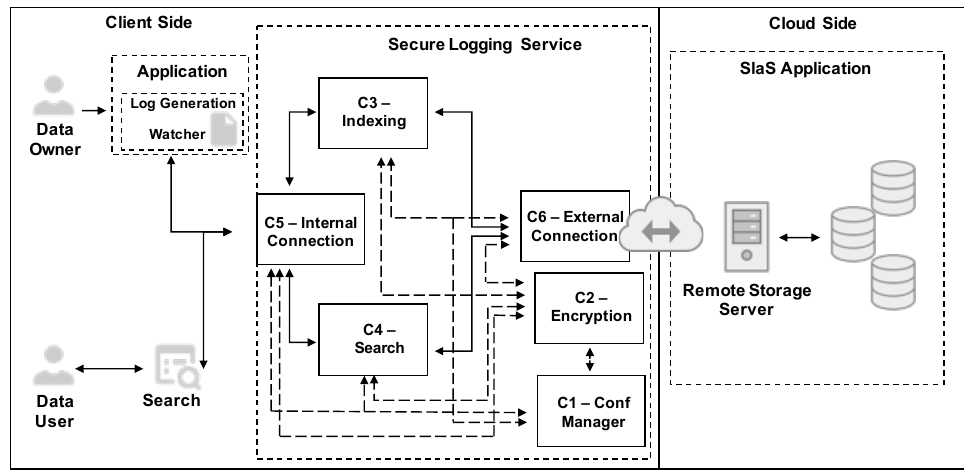
Figure 3. Architecture of the proposed